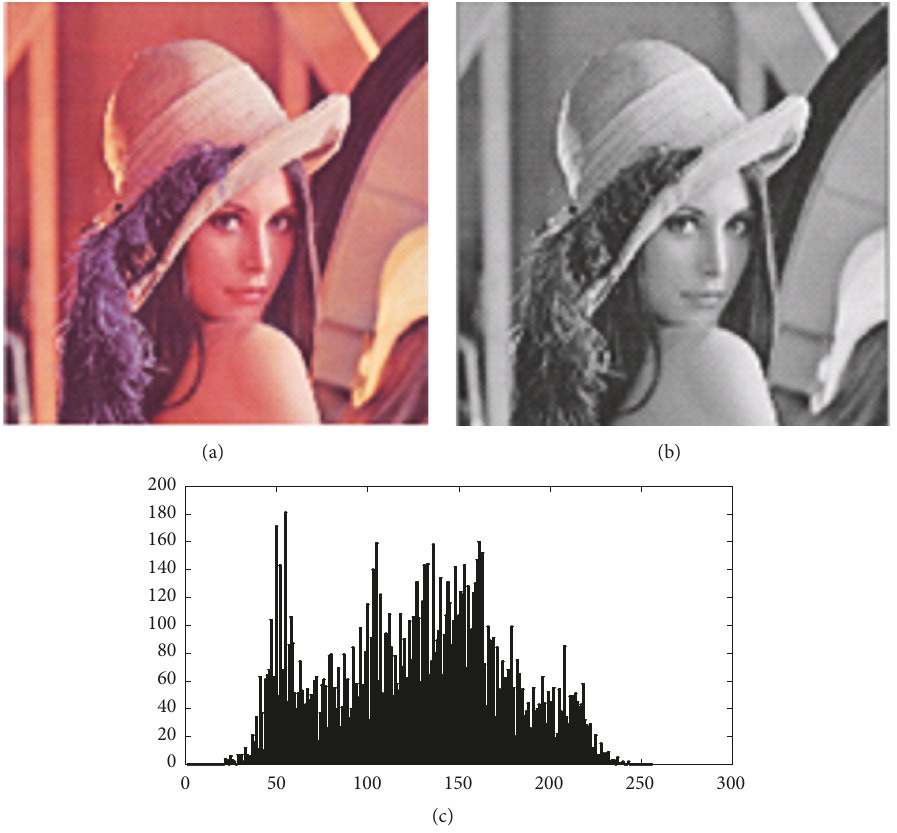
Figure 2: (a) Original photo, (b) gray-scale maps, and (c) gray-scale transformation into histograms (the abscissa represents the gray level and the ordinate represents the frequency of the gray scale (that is, the number of pixels)).